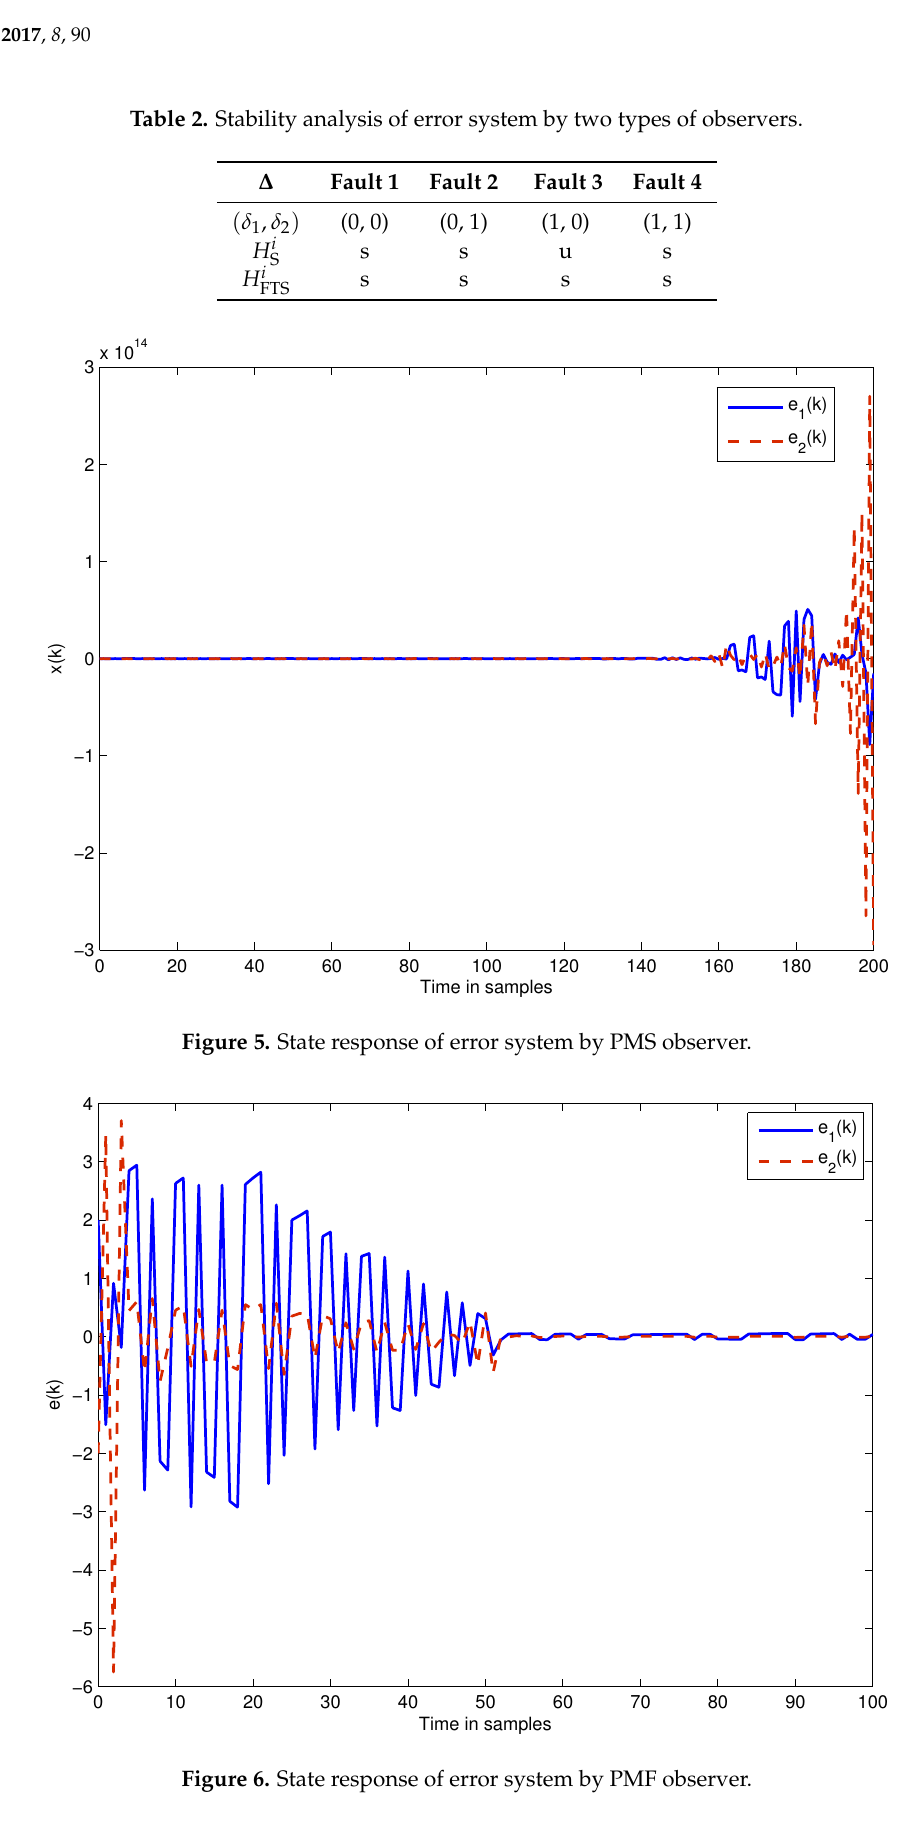
Figure 6. State response of error system by PMF